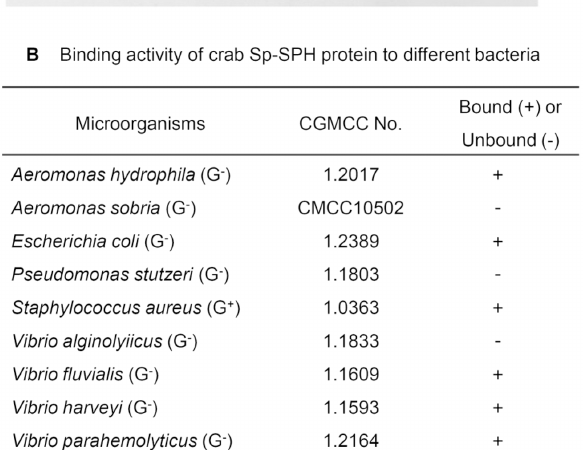
bottom of the 96-well ELISA plate and the content was dried up completely for 2 h at 60 u C. Then, the redundant LPS, PGN or b - 1,3-glucan were washed away by PBS buffer and the non-specific binding were blocked with 5% (w/v) BSA in PBS buffer for 1 h at room temperature. Binding of the serial dilution of the purified Sp- SPH protein (0 , 200 m g/mL, 100 m L/well) was carried out for 1 h at room temperature. The wells without recombinant protein incubation were used as control treatments. After washing the excess protein with PBS buffer containing 0.05% Tween 20, the ELISA plate was hybridized with the mouse anti-SPH antibody (1:1000 dilution, 50 m L/well) for 2 h at 37 u C. The samples were washed three times as above and followed by incubation with HRP-labeled Goat Anti-Mouse IgG (1:1,000 dilution, 50 m L/well) at 37 u C for 1 h. The colorimetric reaction was next detected by adding 100 m L of TMB. After the sufficient blue color formed, 1 M H 2 SO 4 was added to terminate the reaction. Absorbance of each well was measured at 450 nm by a Multifunctional